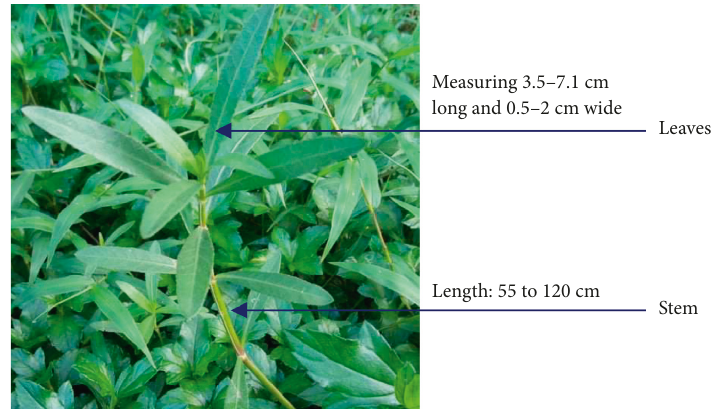
Figure 1: Distinguishing features of Alternanthera philoxeroides